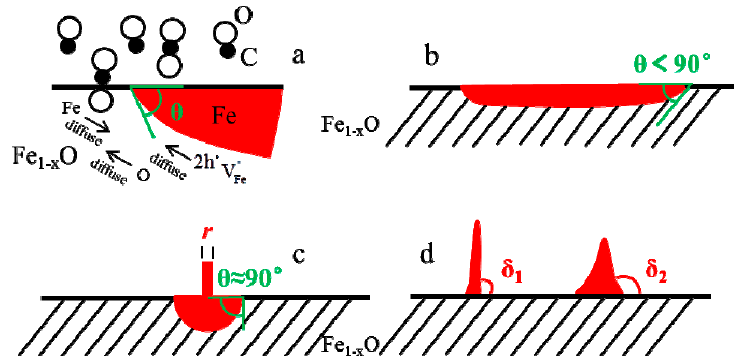
Figure 14. Schematic diagram of the reduction process of the Fe 1-x O phase ( a ) and the mechanism on the generation of metallic iron ( b,c,d ).